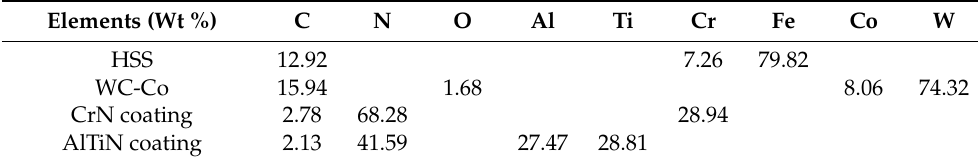
Table 3. Chemical element compositions of substrates and coatings detected via EDS.